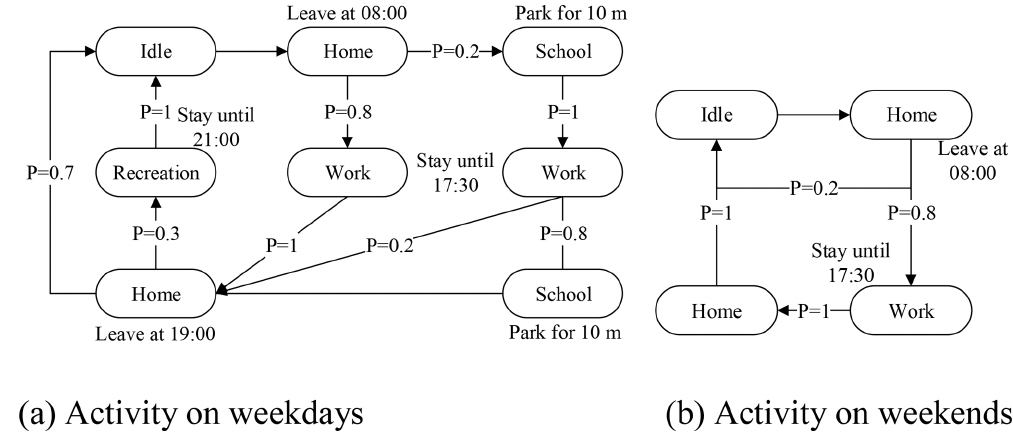
Figure 4. A synthetic daily routine generated from the travel survey and census data for an employed male agent aged 18–60